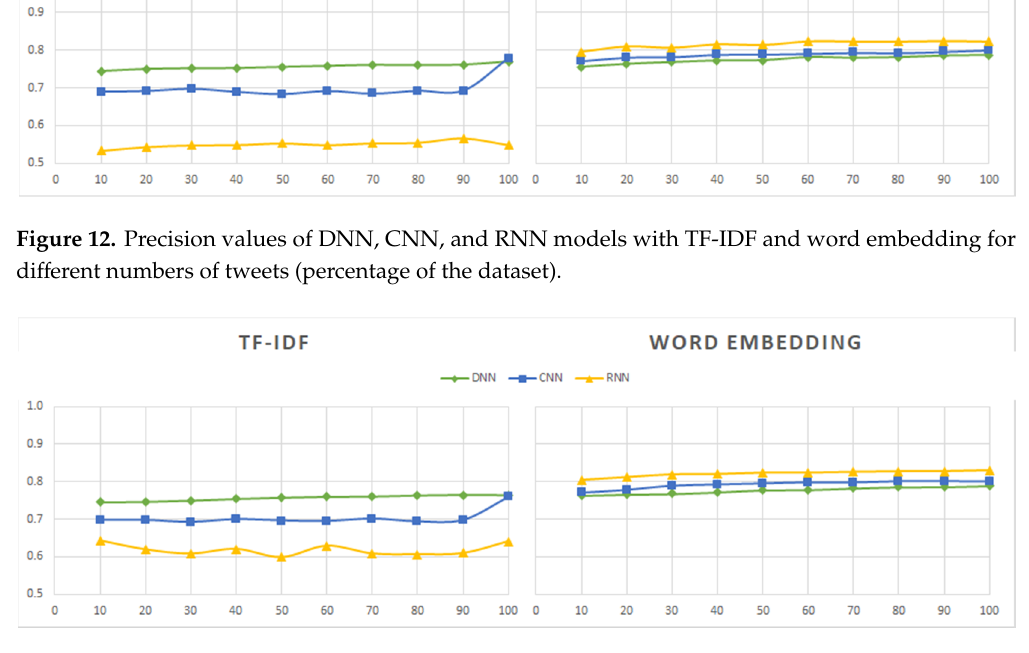
Figure 13. F-score values of DNN, CNN, and RNN models with TF-IDF and word embedding for different numbers of tweets (percentage of the dataset).